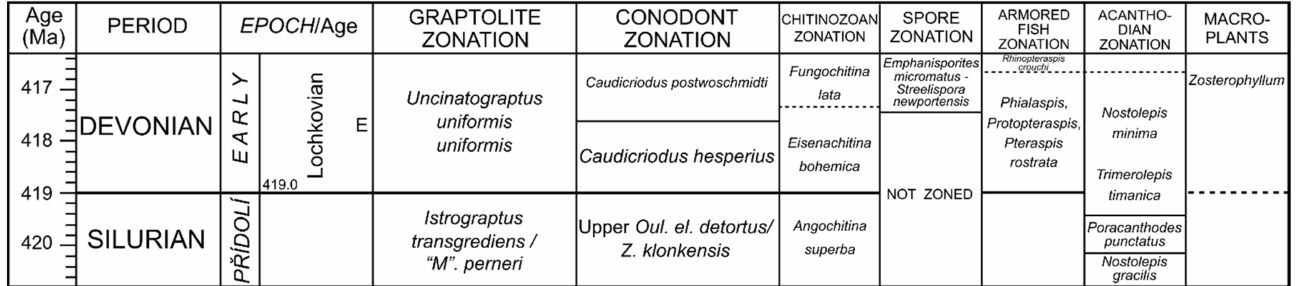
Figure 1. Main biostratigraphical markers across the Silurian/Devonian boundary. Modified after Becker et al. (2020) [15] and Melchin et al. (2020) [7].